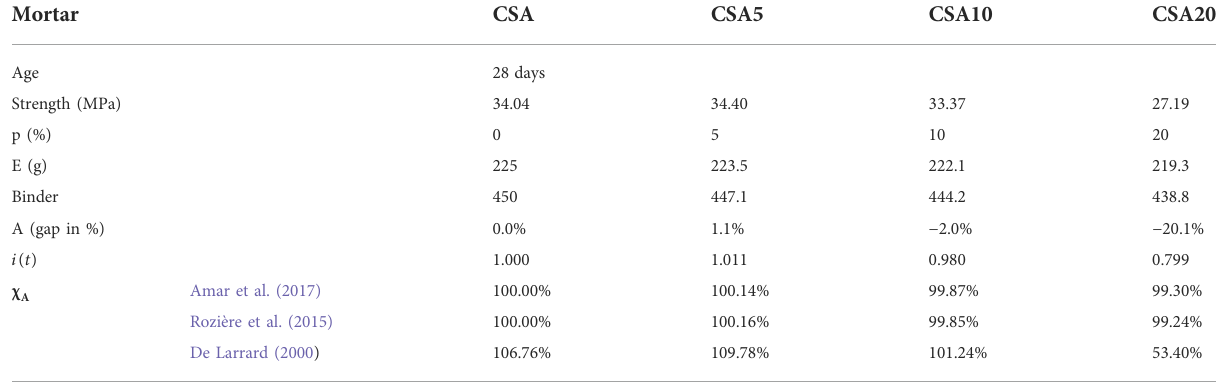
TABLE 5 Activity index and activity coef fi cient calculated at 28 days. Mortar